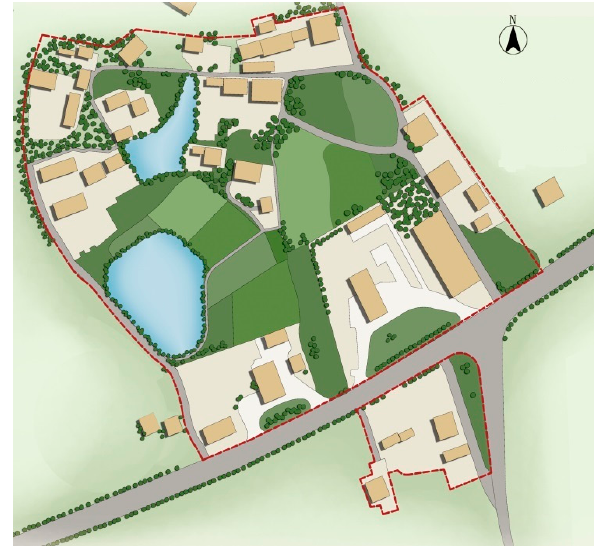
Figure 1. Plan of Nanshan village in Jurong.